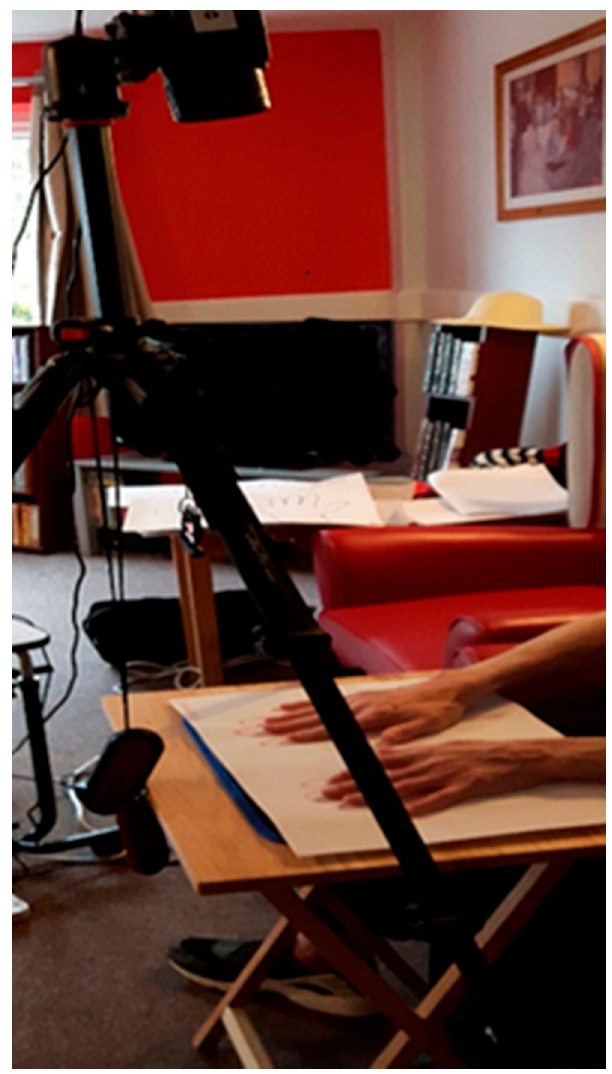
Figure 1. Long wave infrared imaging detector mounted on a tripod. The figure shows the participant during imaging with hands positioned upon a paper ‘hand template’ overlying an insulated tile. The portable table was used throughout the study to ensure consistency of the imaging set-up. This provided visual orientation to the participants for the placement of fingers and hands in a consistent position and to obtain a clear field of view (FOV). After checking detector focus and distance, a maximum of three images were obtained. Colour thermal maps were obtained using a proprietary FLIR software (FLIR Systems AB, Täby, Sweden) and colour palette (see Figure 2). In this paper, data were reported of the dorsum of the hand as this was the most comfortable position for older participants. The colour palette, with temperature key, shows darkest colours (indigo / blue) representing the lowest skin temperature and bright colour (white / yellow) highest temperatures (Figure